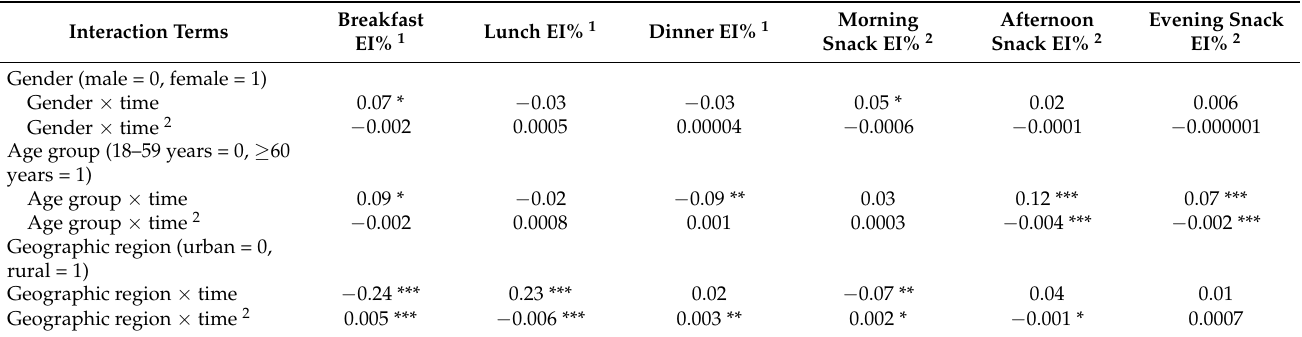
Table 3. Interaction between time and demographic